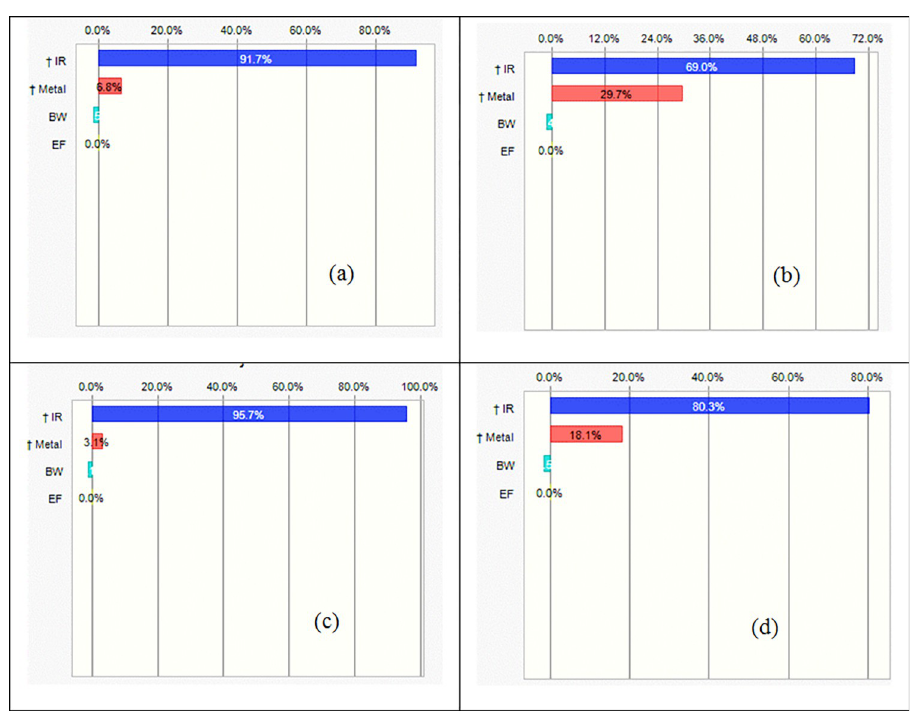
Fig 4. Sensitivity analysis of HI total for (a) vegetables irrigated with TWW for children, (b) vegetables irrigated with TWW for adults, (c) vegetables irrigated with IWW for children, and (d) vegetables irrigated with IWW for adults.